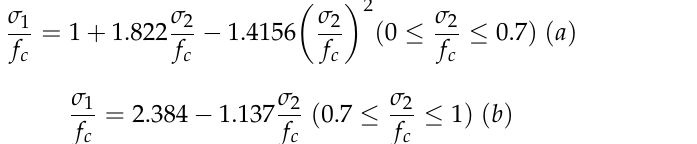
Figure 4. Fitting curve under ECC biaxial compression and experimental results under normalization. By observing the distribution of the sample’s average ultimate strength, when the lateral pressure level is 0–0.7, the part averages approximately a binomial distribution, and when the lateral pressure level is 0.7–1.0, it is roughly a linear distribution. On this basis, the ECC biaxial compression failure criterion is established: σ 1